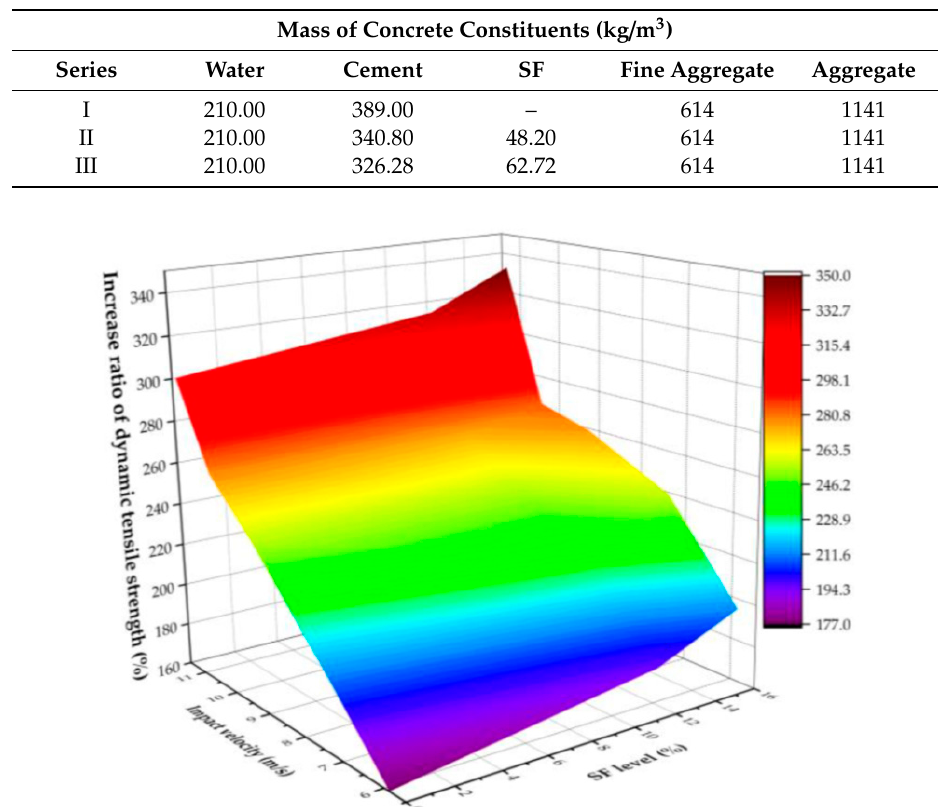
Figure 4. Dynamic tensile strength under different impact velocities and silica fume levels [67].